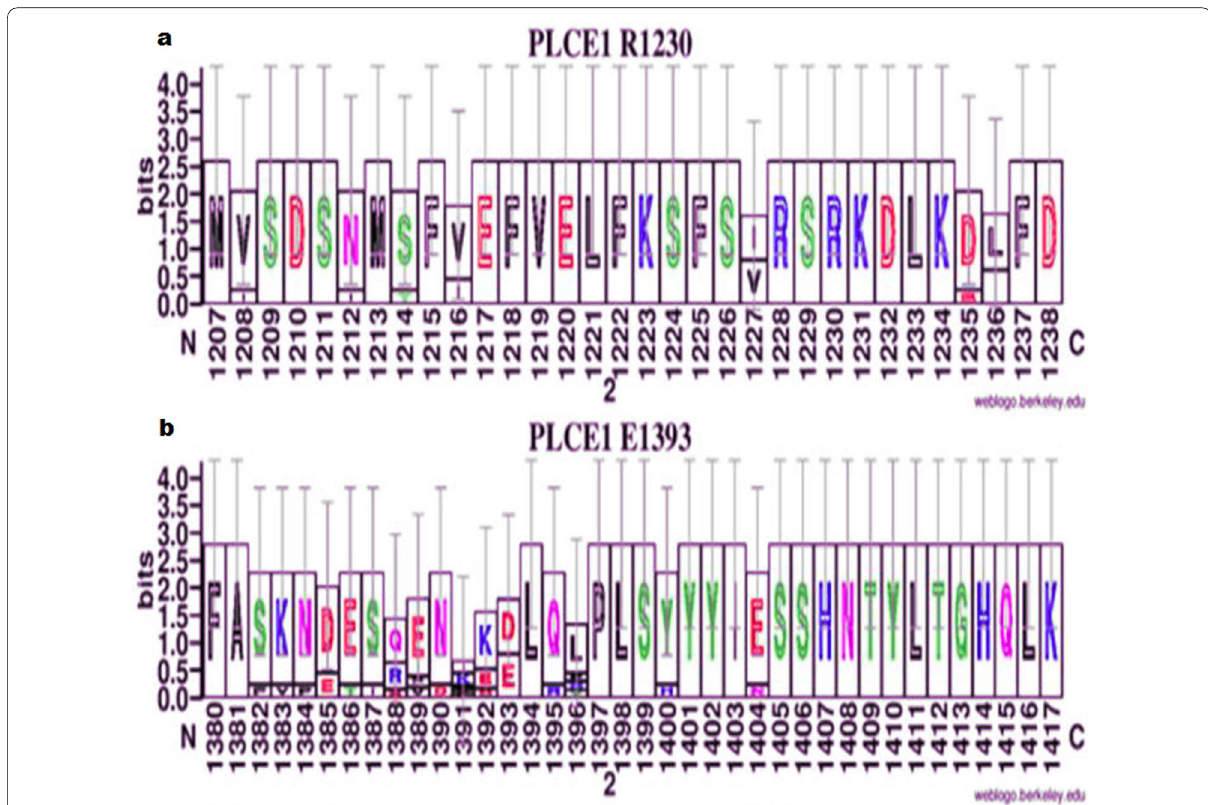
Fig. 4 The WEBLOGO representation of amino acid conservation: input data as Clustal format according to multiple sequence alignment of PLCE1 between human and other organisms. 60 amino acids for PLCE1 protein(Q9P212) Homo sapiens (NP_057425.3), along with seven proteins from Gallus gallus(XP_015144344.2), Canis lupus familiaris (NP_001130037.1), Mus musculus (NP_062534.2), Rattus norvegicus (NP_446210.1), Pan troglodytes (XP_009457233.3) and Danio rerio (NP_001155125.1) and (even in PLC210 the most primitive othologe of PLCE1) Caenorhabditis elegans (AAC38963.1) a represent the logo representation of aligned positions containing R1230 (according to human sequence) While b represent the logo representation of 60 amino acids of the same organisms but in position containing the other mutant amino acid E 1393 (according to human sequence) show low conservation score than